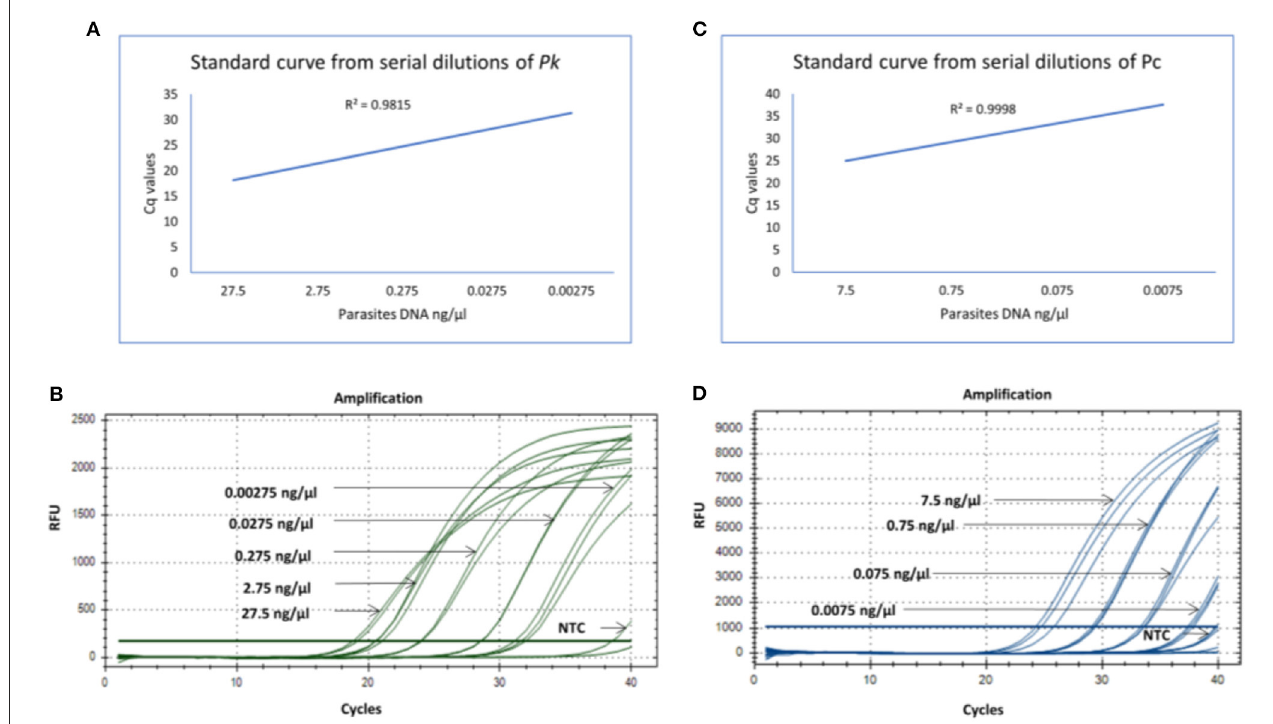
FIGURE1 (A) Standard curve generated from 10-fold serial dilutions from known concentrations of parasites DNA (Pk) in the qPCR assay. (B) qPCR amplification cycles for Pk serial dilutions with fluoroscent probe HEX (green). (C) Standard curve generated from 10-fold serial dilutions from known concentrations of